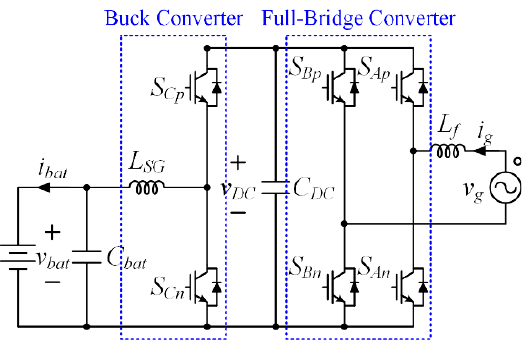
Figure 2. Simplified circuit configuration of integrated OBC which performs battery charging.